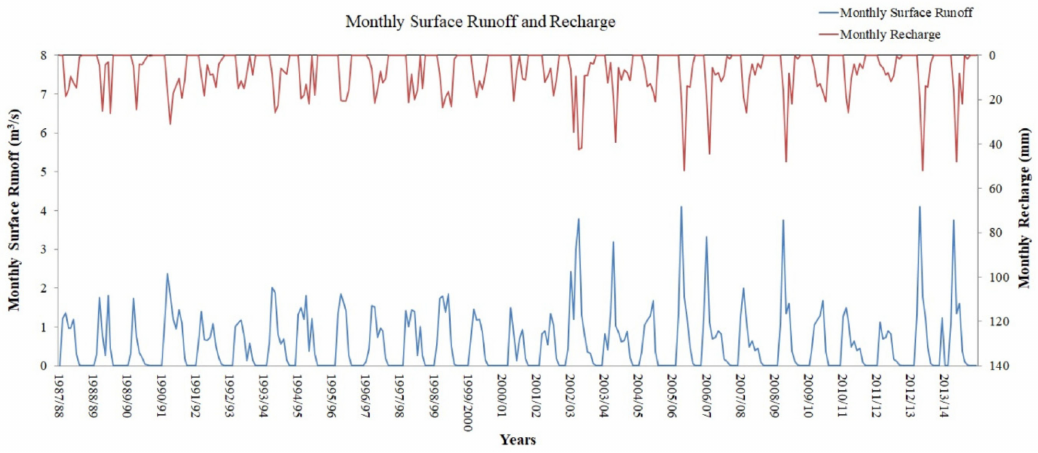
Figure 5. Graph of surface runoff and recharge monthly values generated by UTBAL